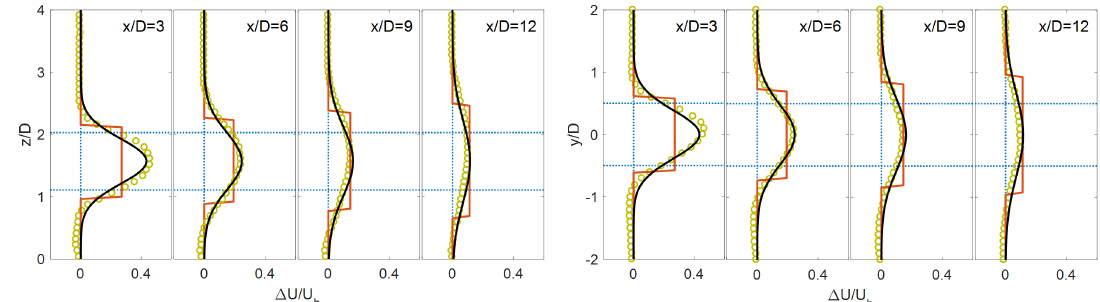
Figure 2. Normalized velocity defect profiles ( ∆ U / U h ), in wall-normal ( left ) and spanwise ( right ) directions, through the turbine center downstream for Case (1). LES data (open circle), top-hat model (solid red line), and Gaussian model (solid black line). The horizontal dotted lines denote the turbine extent.